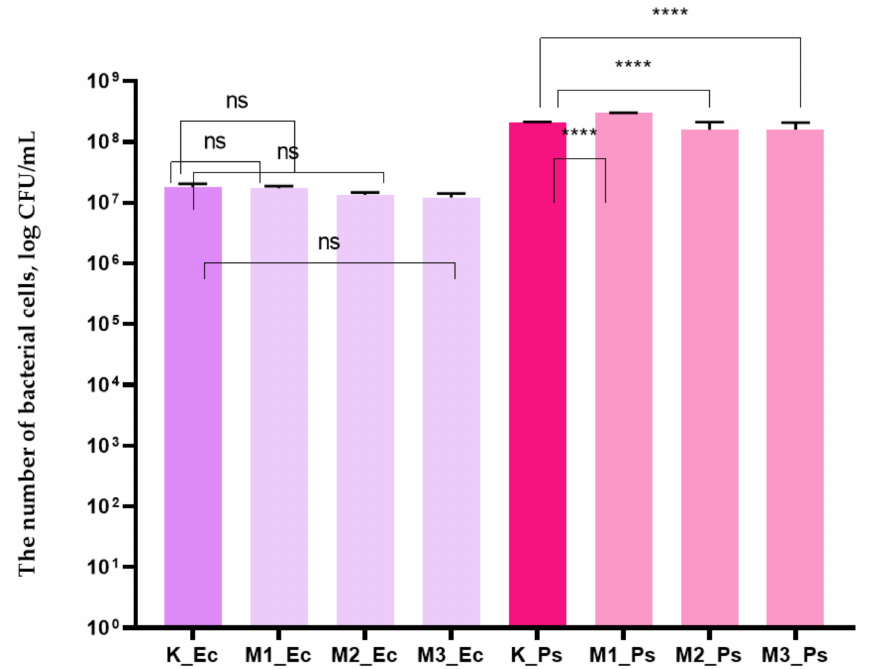
Figure 7. The influence of coatings on E . coli and P. syringae growth. One-way ANOVA: ns—not significant; ****— p <